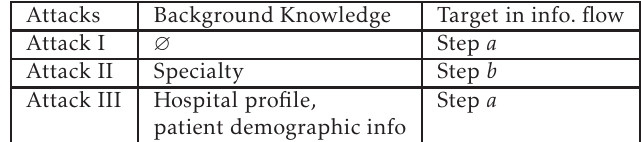
Table 2. Attacks: The considered attacks are classified by the type of background knowledge used in the attack and the information flow through which the adversary gets to the privacy-disclosing fact on “the patient’s disease.”